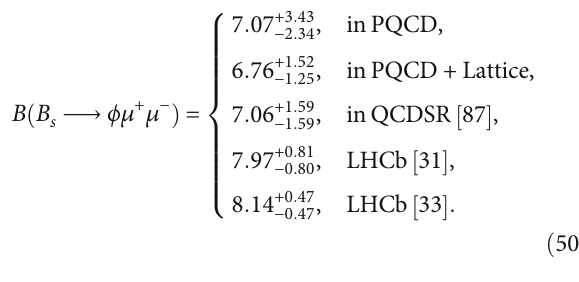
f veto = 1 : 52 is applied to account for the contribution in the veto q 2 bins for ℓ = ð e , μ Þ cases. As a comparison, we also ⟶ ϕμ + μ − Þ = ð 7 : 9 show the LHCb measured value B ð B s Þ × 10 − 7 [31] and ð 8 : 14 +0 : 47 Þ × 10 − 7 [33] and the 7 +0 : 81 − 0 : 80 − 0 : 47 ⟶ ϕ ℓ + ℓ − Þ for all three decay QCDSR predictions B ð B s ⟶ ϕμ + μ − decay, for instance, the theo- modes [87]. For B s retical predictions and the LHCb measurement [31, 33] (in unit of 10 − 7 ) are the following: